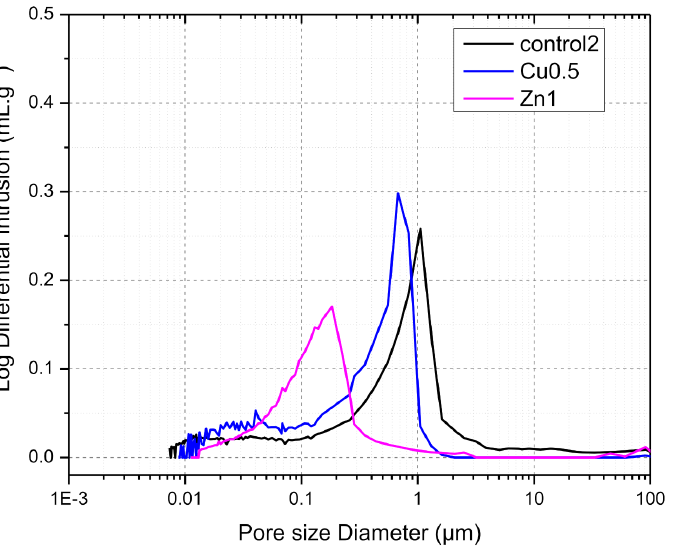
Figure 8. Pore size distribution (intrusion log differential, mL · g -1 vs. pore size diameter, µ m) of selected samples of GWC IPs (control) with 0.5% CuO and 1% ZnO